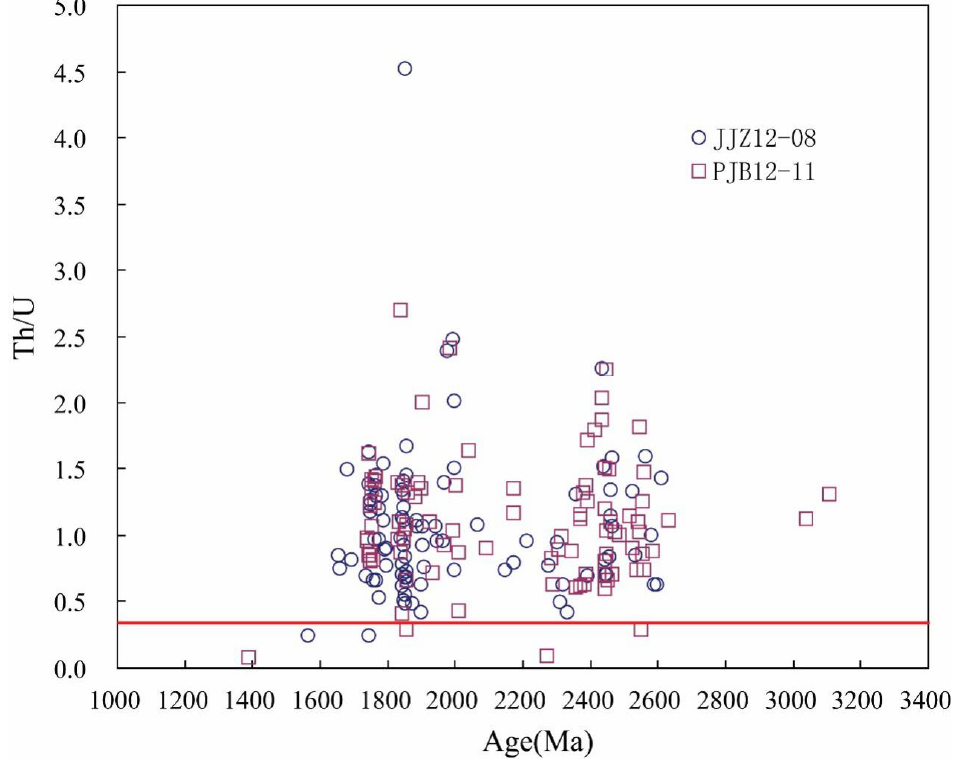
Figure 5. Th/U values of zircon grains with 207 Pb/ 206 Pb ages.